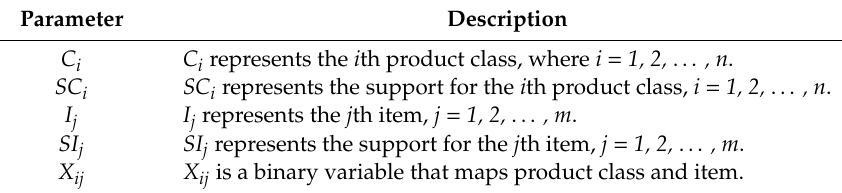
Table 2. Parameter definition of “classification of items (COI)”.